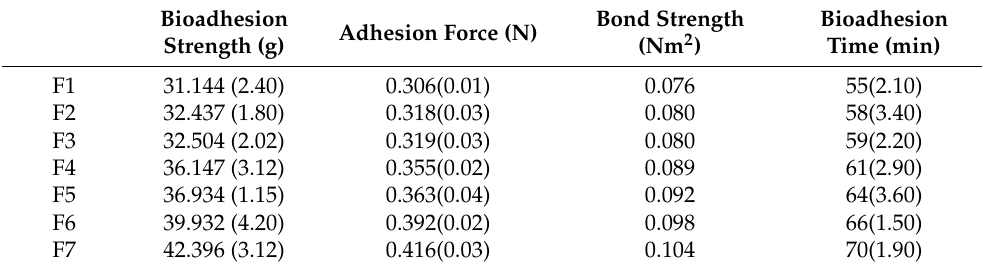
Table 3. Bioadhesion strength, adhesion force, and bioadhesion time of the different prepared bio-adhesive